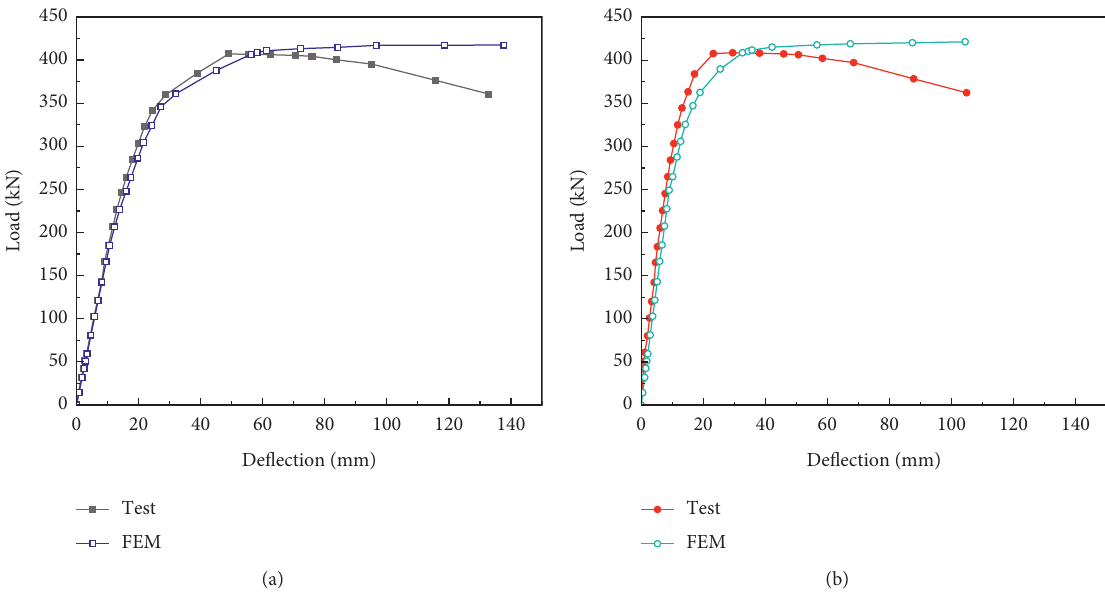
Figure 8: Load-deflection relationships at the loading section: (a) outer girder G1; (b) inner girder G2.